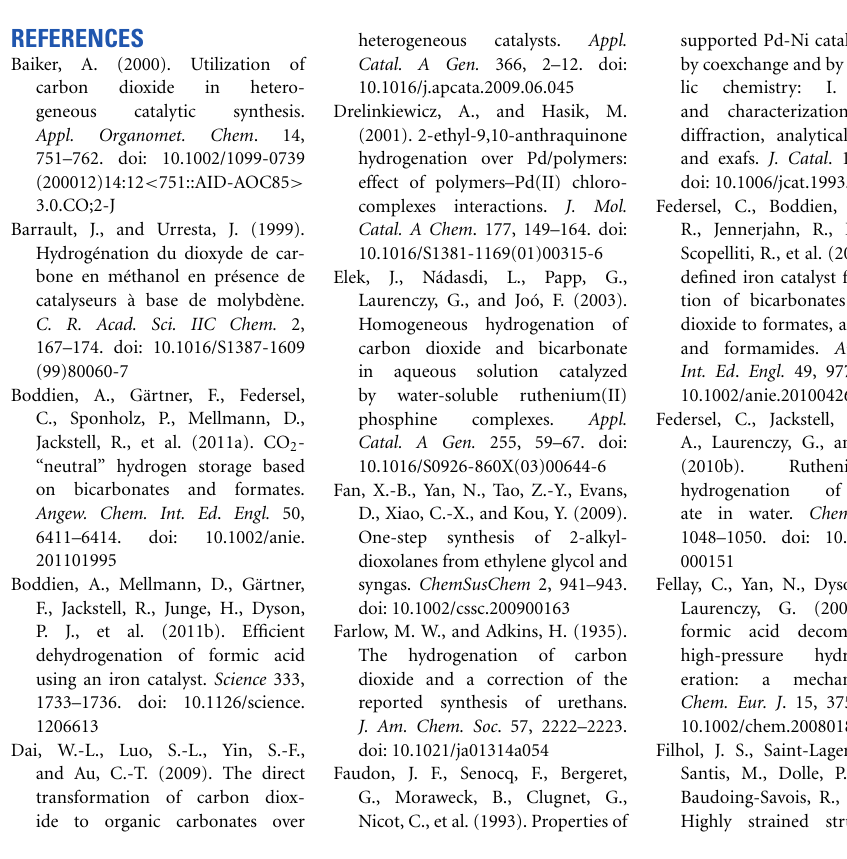
the presence of 5 bar CO 2 , the TOF of the Ni 7 Pd 3 NPs increased sharply to 2.8, as compared to 1.2 under CO 2 free